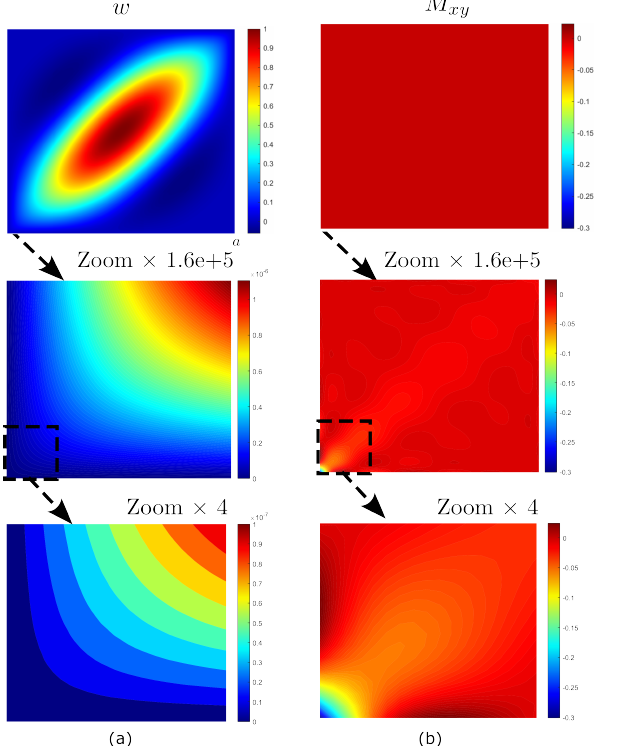
Figure 17. Highly anisotropic plate: mode shapes for buckling analysis: ( a ) deflection shape and ( b ) twisting